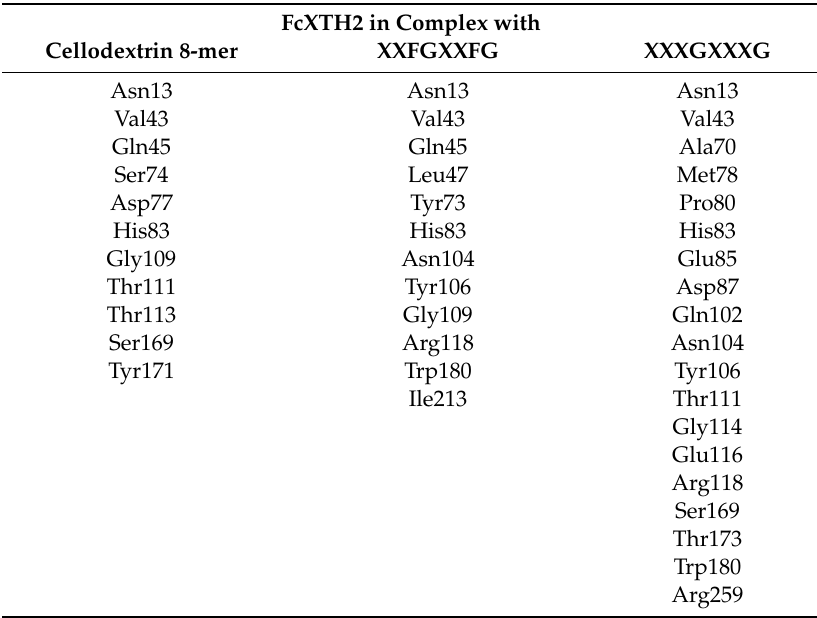
Table 4. List of residues that are located at ≤ 3Å in the complex between FcXTH2 and each ligand tested. The catalytic residues are highlighted in